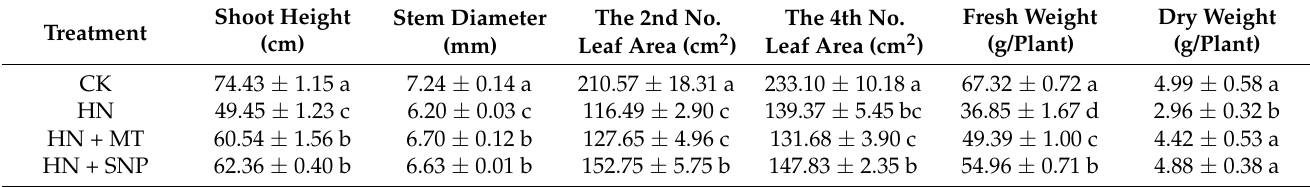
Table 1. Effects of melatonin and nitrate oxide on growth parameters of cucumber seedlings grown under nitrate stress.